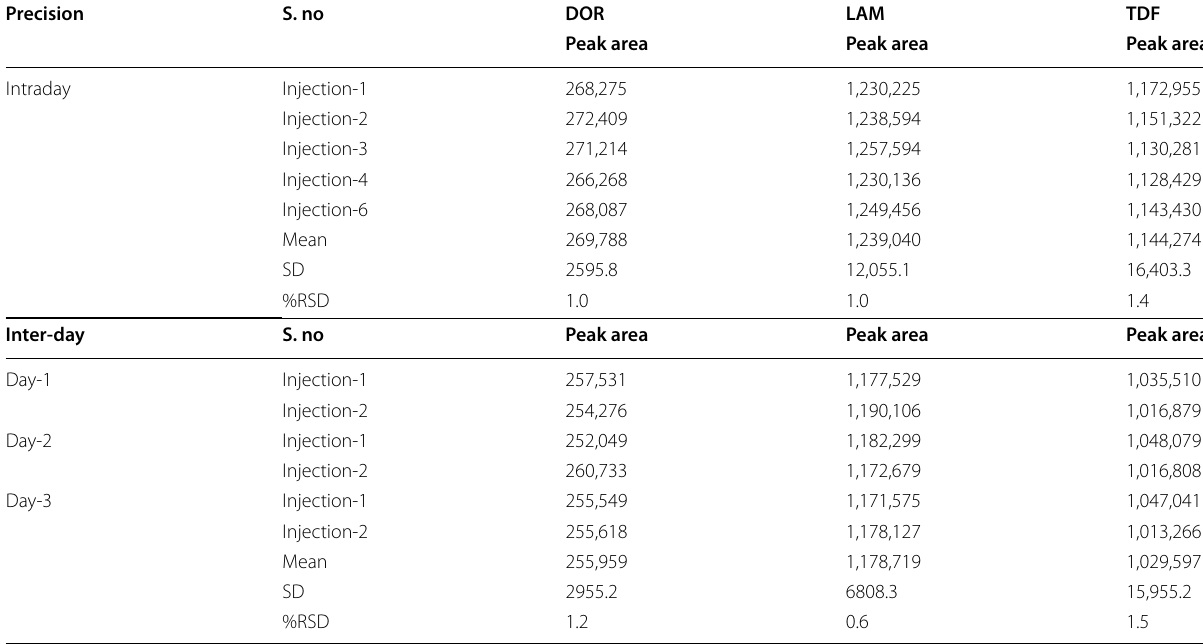
Table 4 Intra-day and inter-day precision data of DOR, LAM and